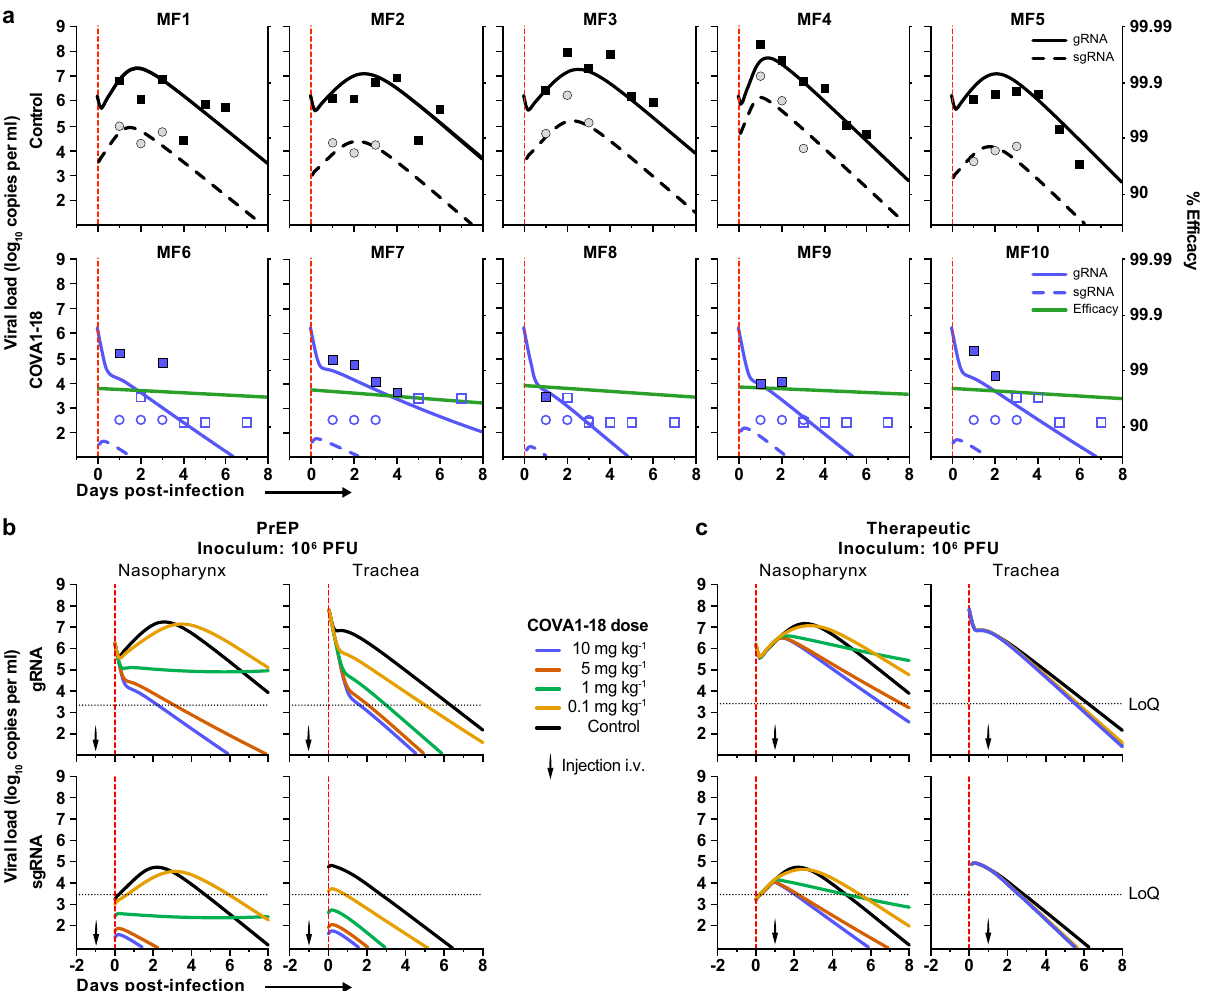
Fig. 4 Modeling of viral dynamics and treatment ef fi cacy. a Individual prediction of the nasopharyngeal genomic (g)RNA and subgenomic (sg)RNA in control (top) and treated animals (bottom) with individual ef fi cacy prediction indicated (green line). The dashed red line indicates the time of infection. gRNA (squares) and sgRNA (circles) data are indicated as plain (above LoQ) or open (below LoQ). b Model predictions of gRNA and sgRNA dynamics with 4 doses of COVA1-18 given 24 h prior to challenge (arrow). c Simulation as in ( b ) with COVA1-18 given 24 h post-infection. Black dotted lines indicate LoQ (limit of quanti fi cation), i.v. intravenous, PFU plaque forming units, PrEP Pre-exposure